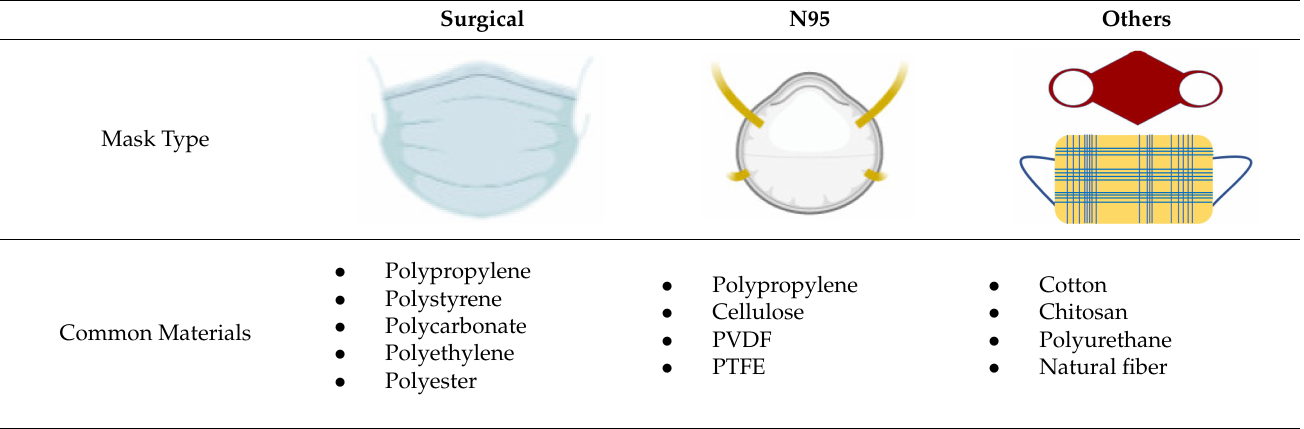
Table 15. Different types of face masks and common materials used.